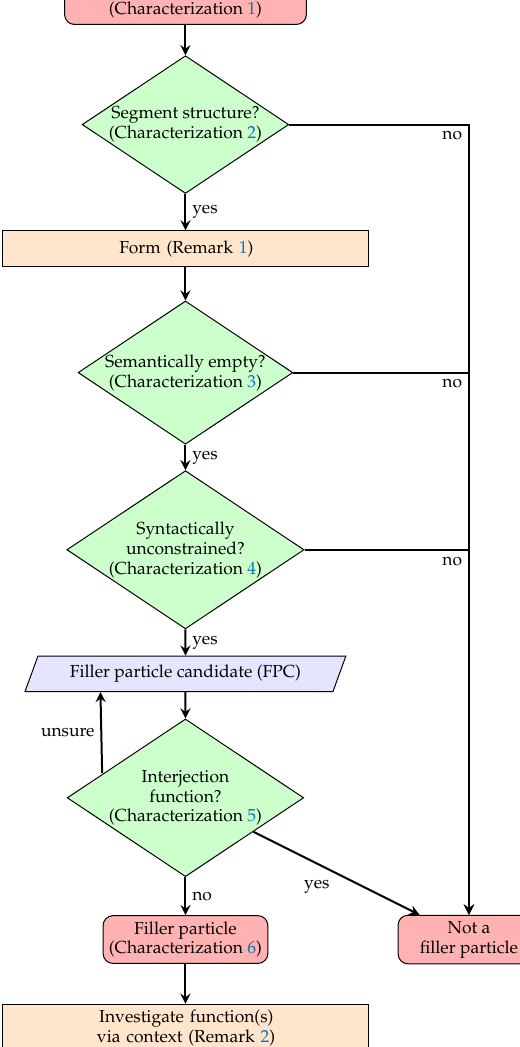
Figure 3. Flowchart for identifying filler particles, with start/end nodes (rounded corners), decision nodes (diamonds), remarks (rectangles), and intermediate outputs (rhomboids).